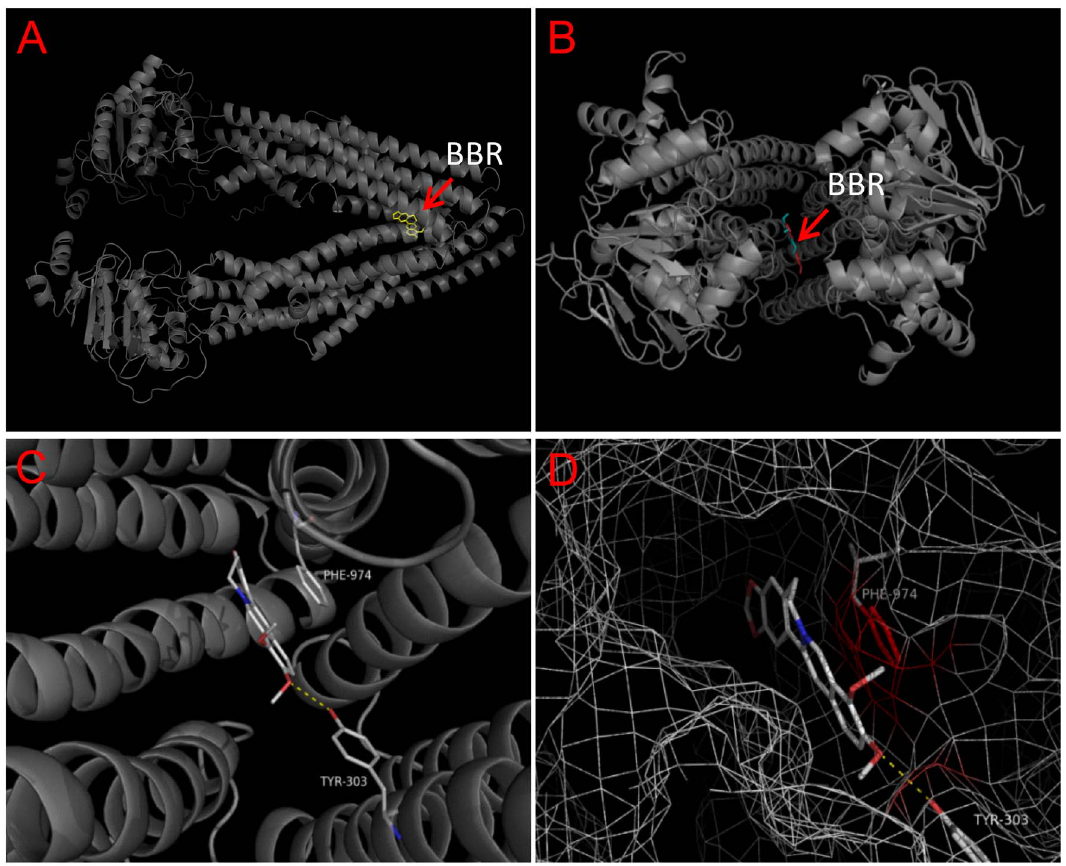
Figure 5. Molecular docking of berberine (BBR) to Homo sapiens P-gp. (A) Side and (B) top view of the BBR binding pocket of P-gp. (C, D) the overall docking views of BBR in the binding pocket of P-gp. Blue mesh: protein’s electron isodensity map around the binding site. Protein are represented as cartoon (transparency=20%), small molecules and important amino acids (as labeled) are represented as lines (white and green, carbon. red, oxygen. blue, nitrogen). Yellow dash line, hydrogen bond.